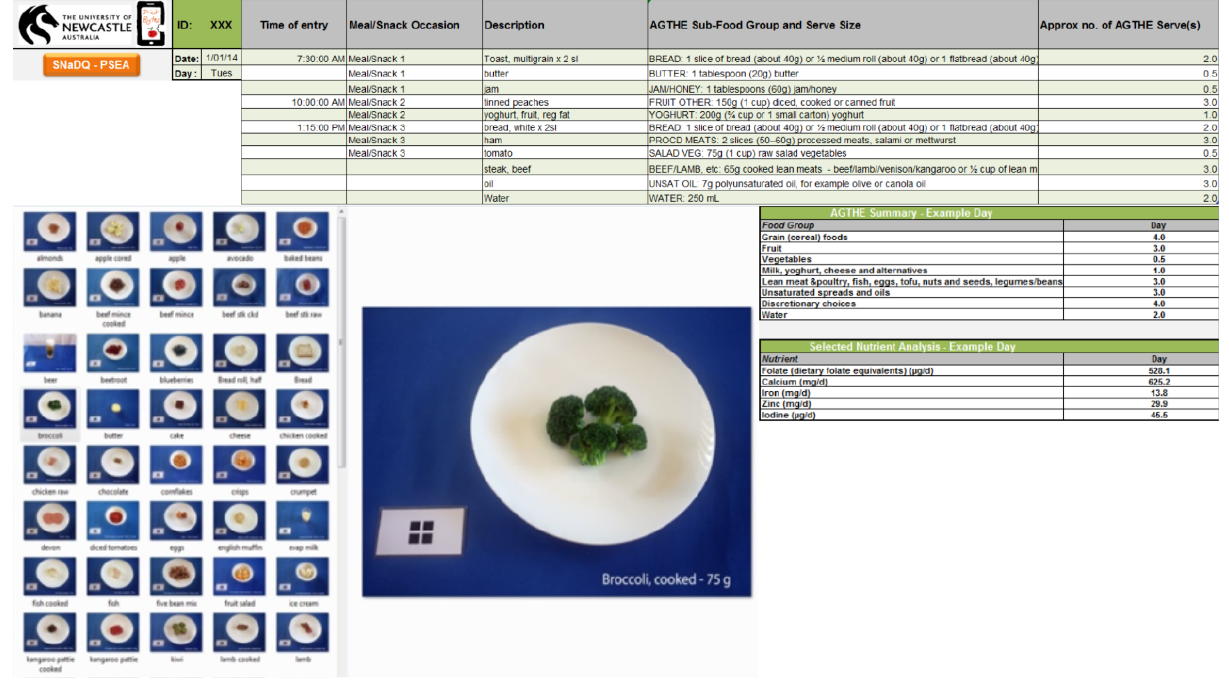
Figure 3. The Selected Nutrient and Diet Quality (SNaQ) analysis tool and portion size estimation aid (PSEA) for analysis of image-based dietary records in the Diet Bytes and Baby Bumps study. AGTHE: Australian Guide to Healthy Eating